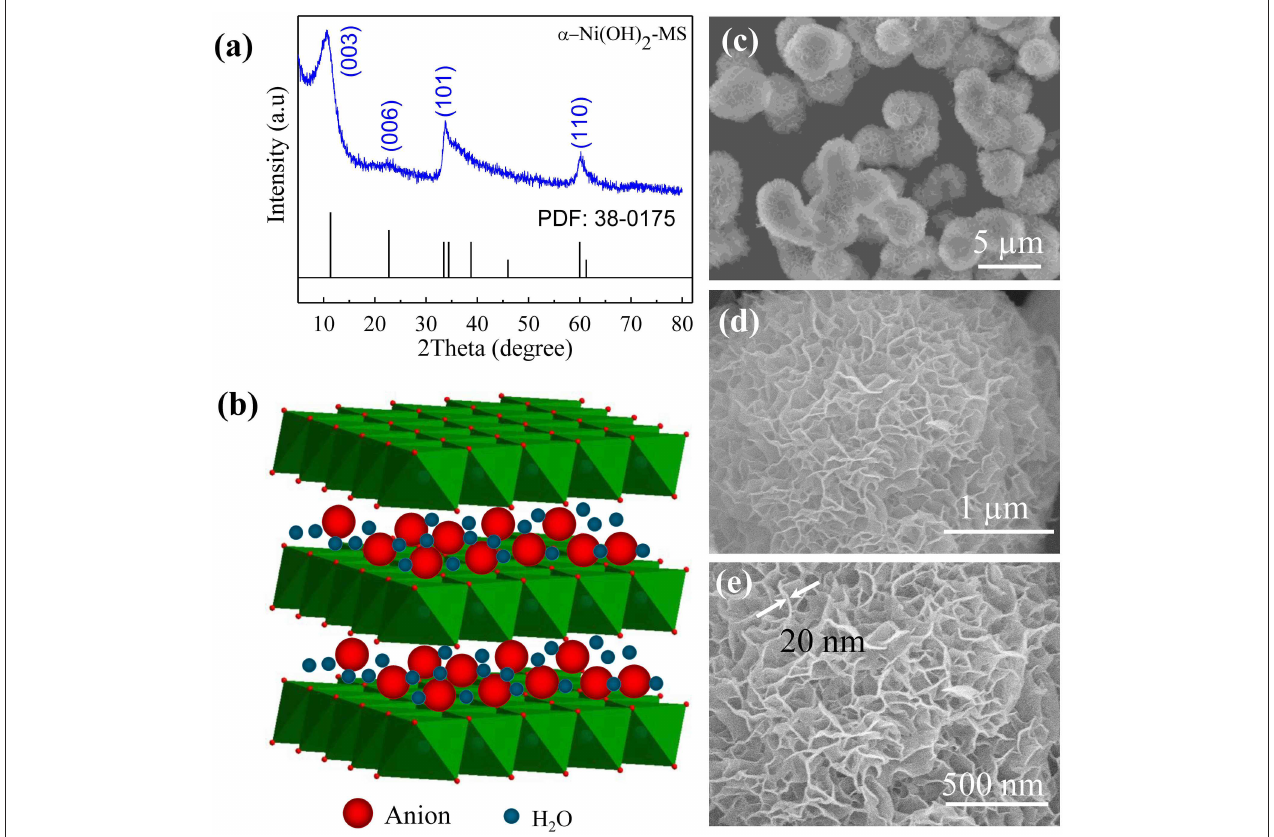
FIGURE 1 | (a) XRD pattern of the as-prepared α -Ni(OH) 2 -MS. (b) Schematic structure of α -Ni(OH) 2 . (c–e) SEM images of α -Ni(OH) 2 -MS at different magnifications.